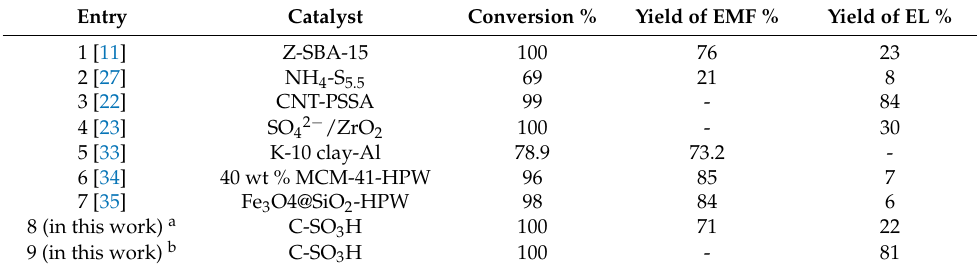
Table 2. The comparison of the catalytic performance of the present work with those reported in the